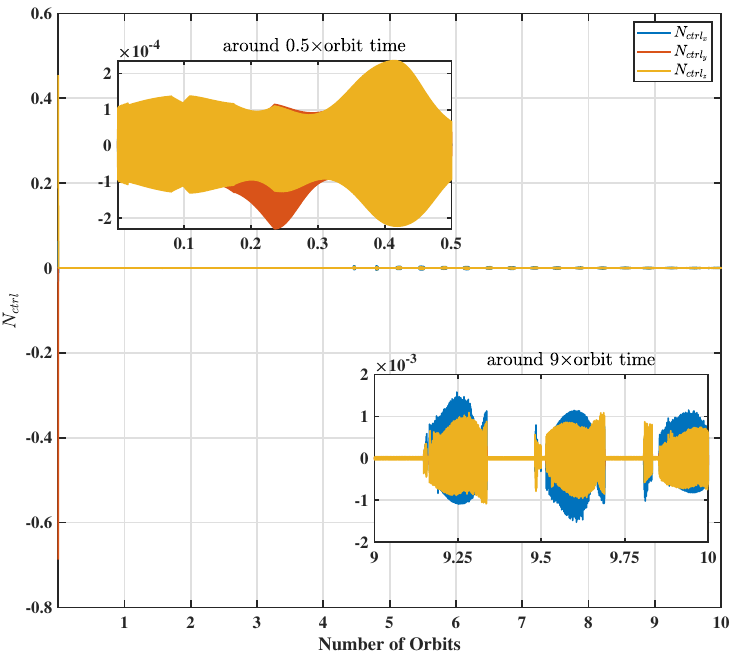
Figure 5. The control torque in N-m corresponding to Figure 3 and Figure 4. The control torque has a high magnitude in the beginning, and this limits the practical application to an extent. The chattering seen in the zoomed-in part around 9th orbit is due to the oscillating controls.